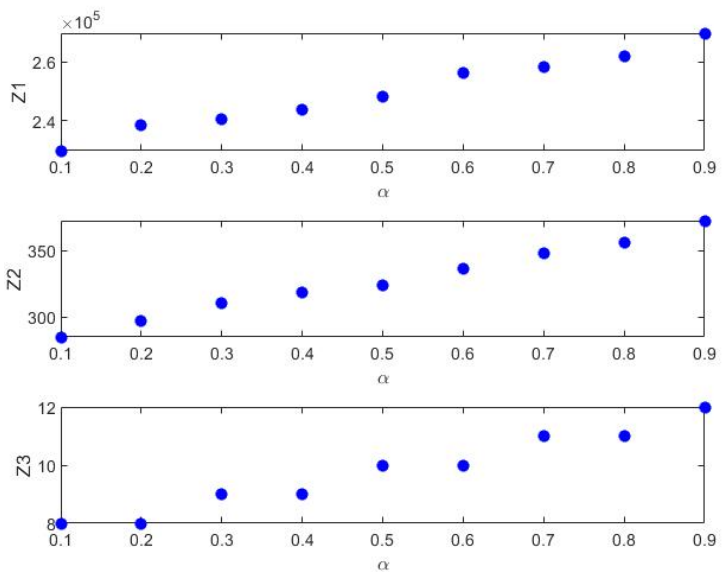
Figure 3. The process of changing the values of objective functions for different rates of uncertainty. The different number of efficient solutions obtained from different methods shows the effectiveness of the solution method operators in solving the optimisation problems.